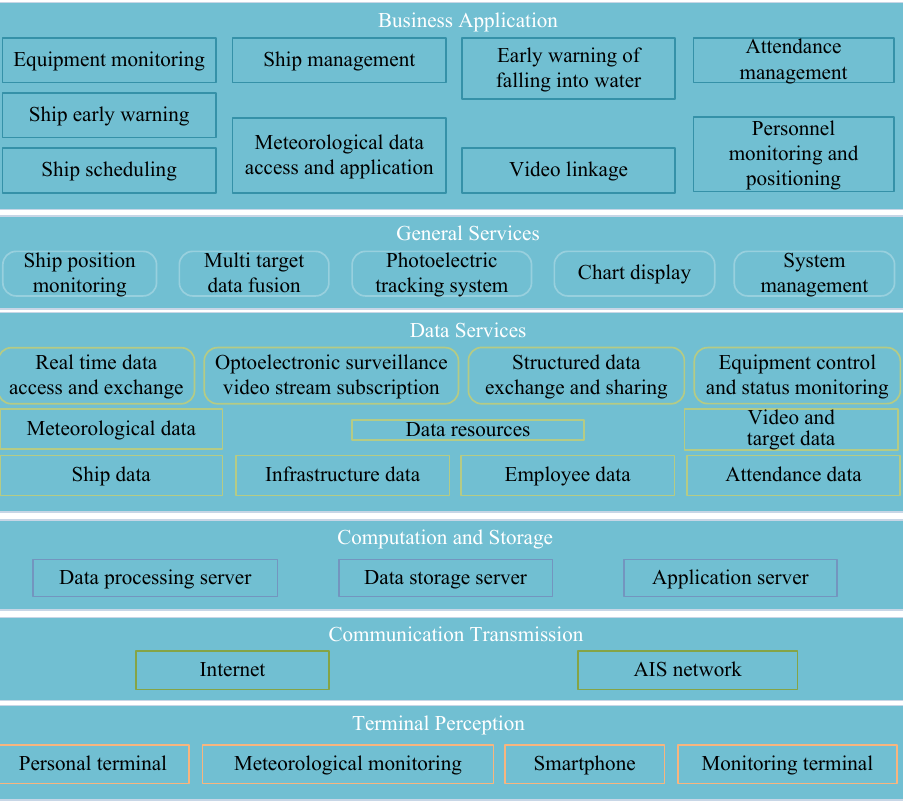
Figure 18. Intelligent dispatching management system of offshore wind farms.